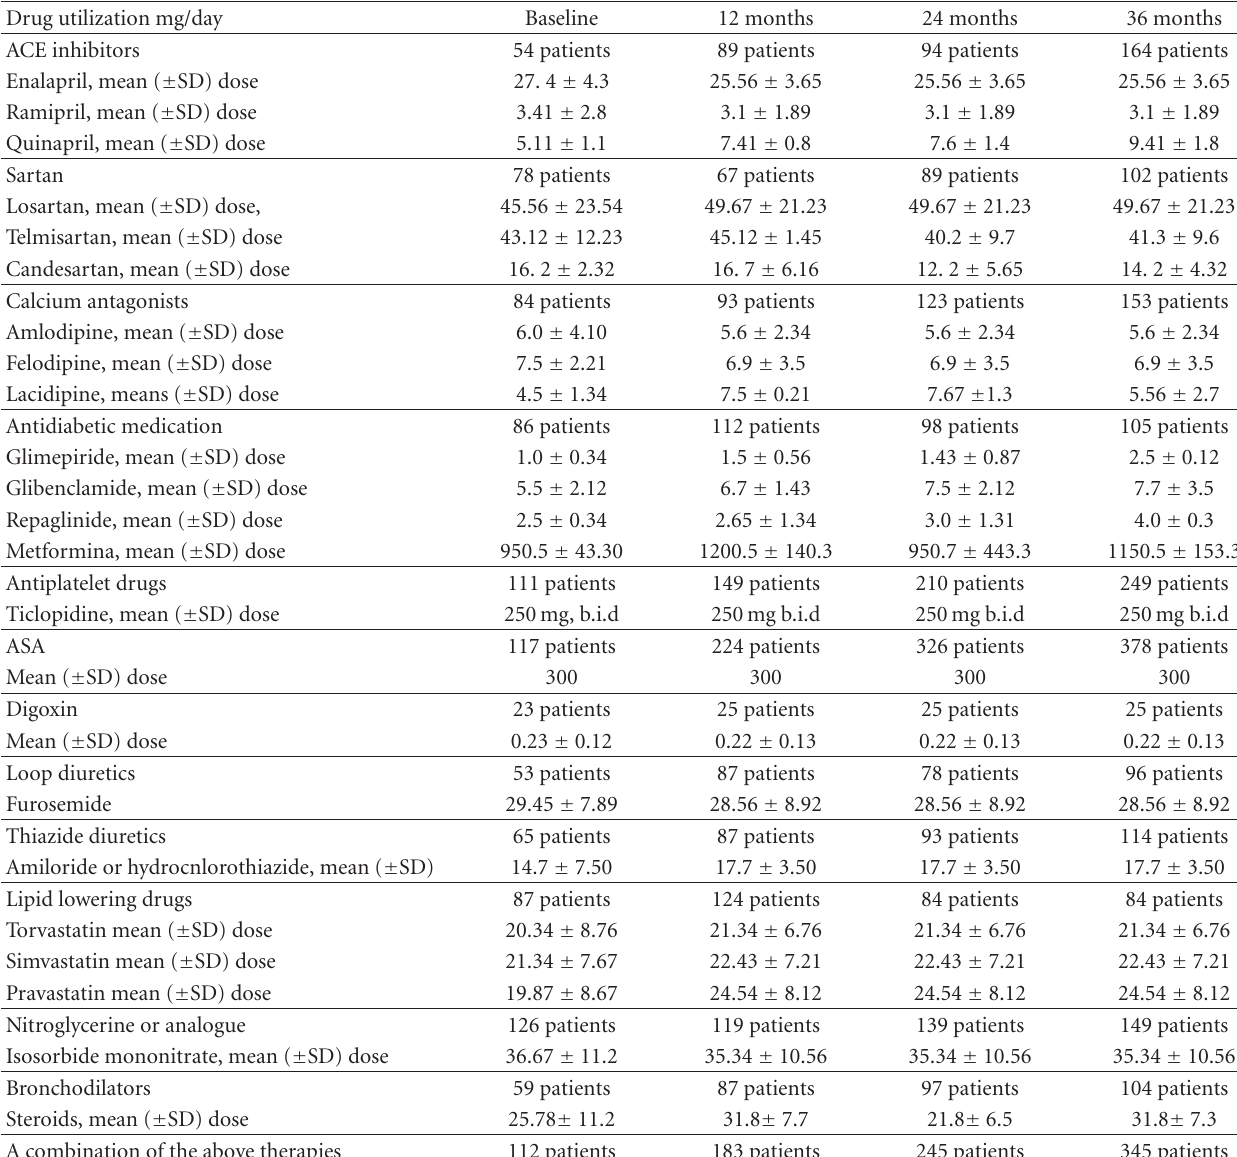
Table 2: A synopsis of the drugs employed by the two groups of patients at baseline.